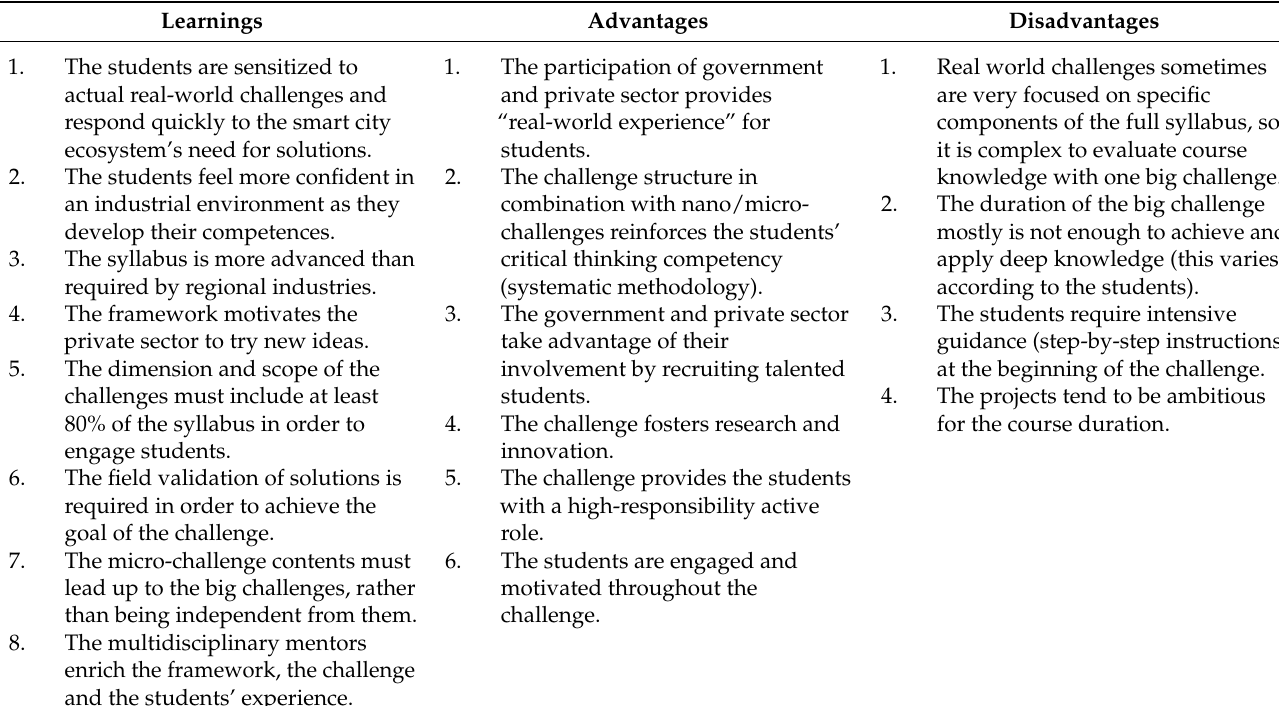
Table 1. Campus City Challenge Living Lab learnings, advantages and